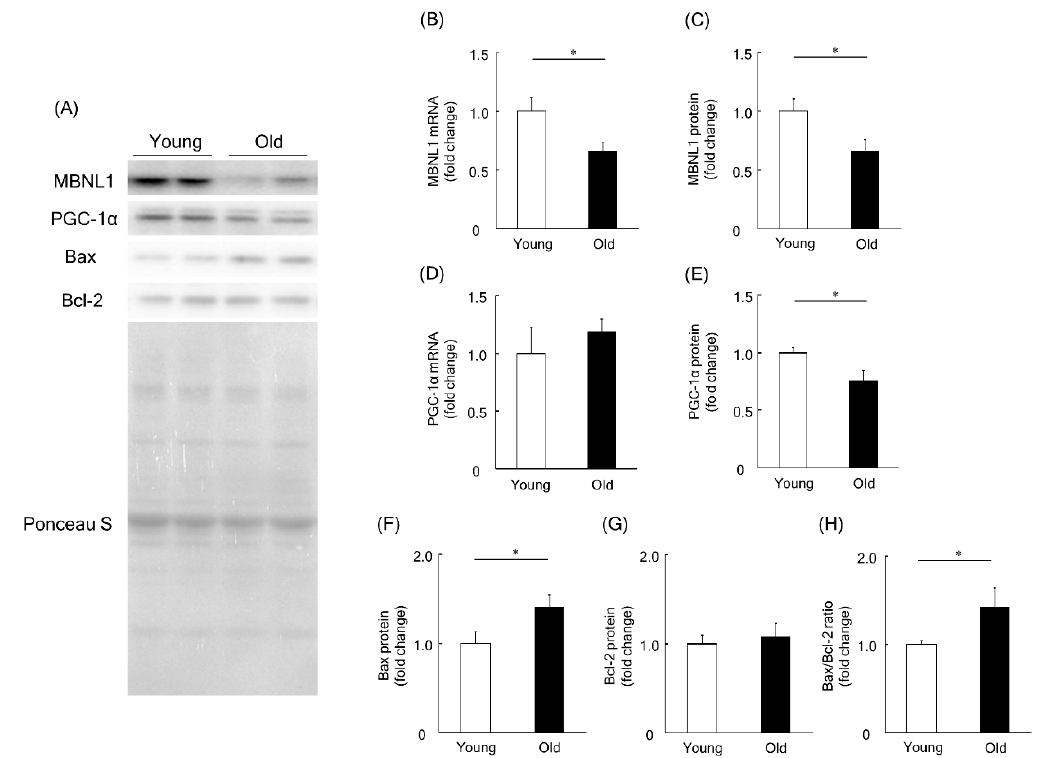
Figure 7. Expression level of MBNL1, PGC-1 α , Bax, and Bcl-2 in plantaris muscles of young and old mice. ( A ) Representative expression patterns of MBNL1, PGC-1 α , Bax, Bcl-2, and loading control Ponceau S staining. mRNA and protein expression level of MBNL1 ( B , C ) and PGC-1 α ( D , E ). The expression level of Bax ( F ) and Bcl-2 ( G ) proteins and the ratio of Bax to Bcl-2 ( H ). Values are means ± SEM; young: 10 weeks old, n = 5; old: 100 weeks old, n = 7. *: p < 0.05.